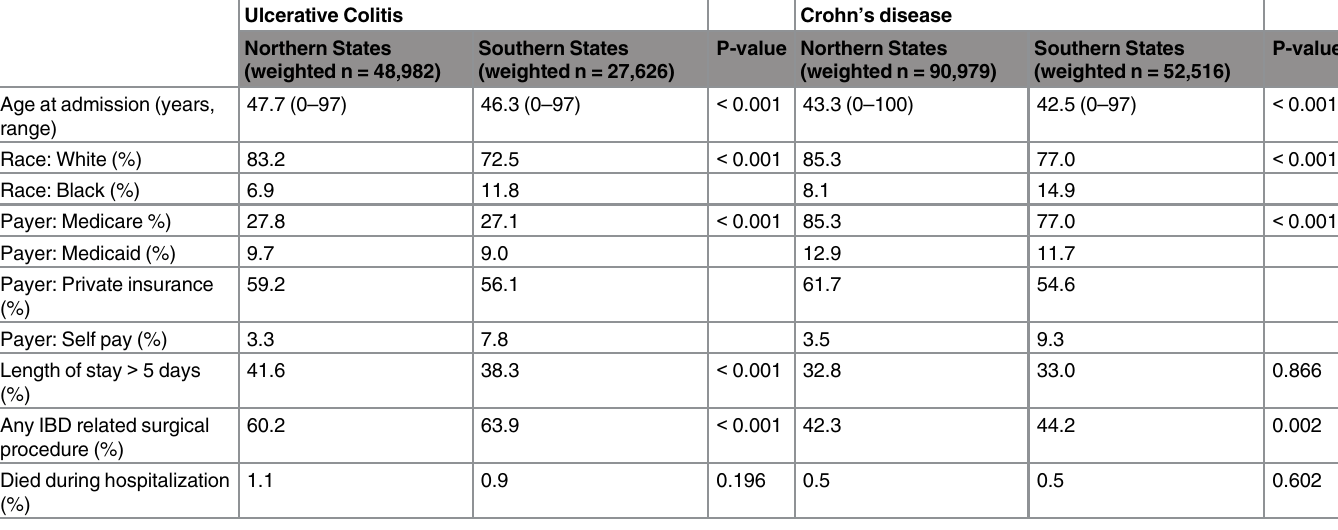
Table 1. Demographic data for patients included in the study from 2001 – 2007. Data is for weighted samples. Ulcerative Colitis Crohn ’ s